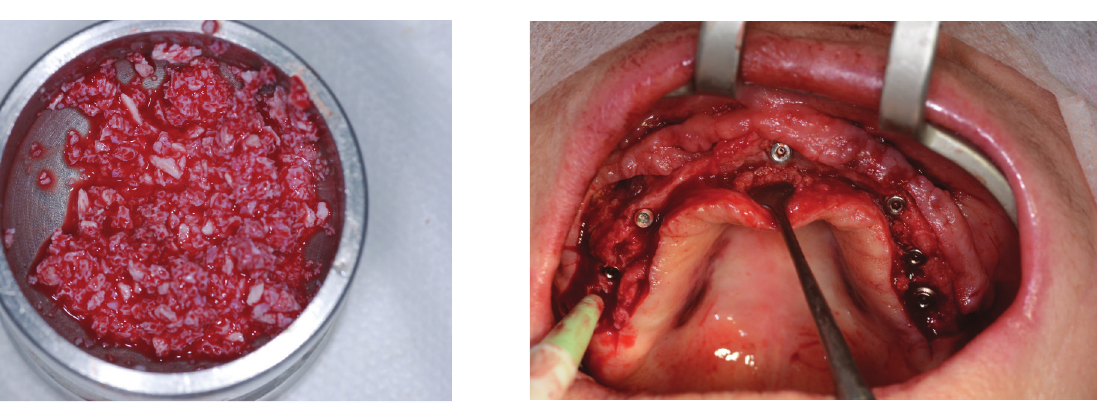
Figure 6: Xenograft combined with the bone marrow concentrate, immediately before being used.